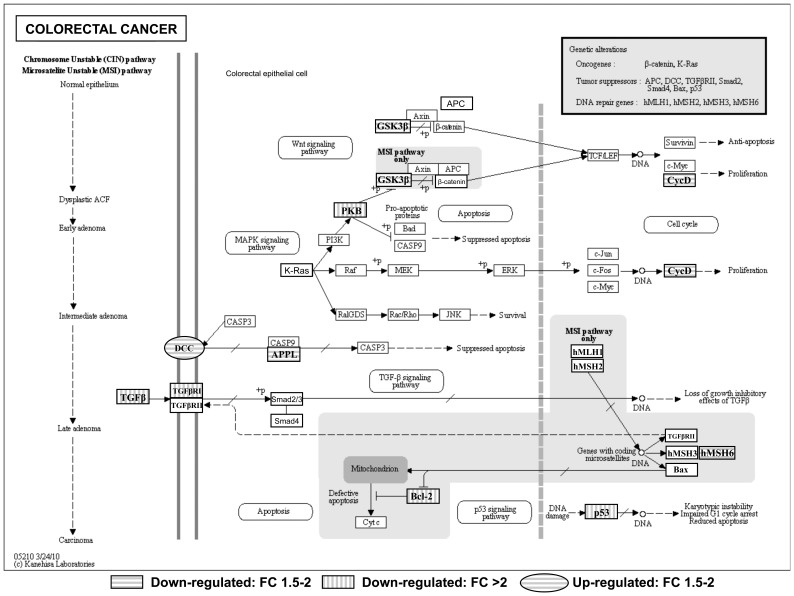
Adaptation of KEGG colorectal cancer pathway using KEGG Mapper.Circular pathway members were significantly up-regulated and rectangular members were found to be down-regulated in the intestinal mucosa of ApcMin/+ mice treated with MA. Horizontal lines indicate a fold change (FC) of between 1.5 and 2 and vertical lines a FC of more than 2.